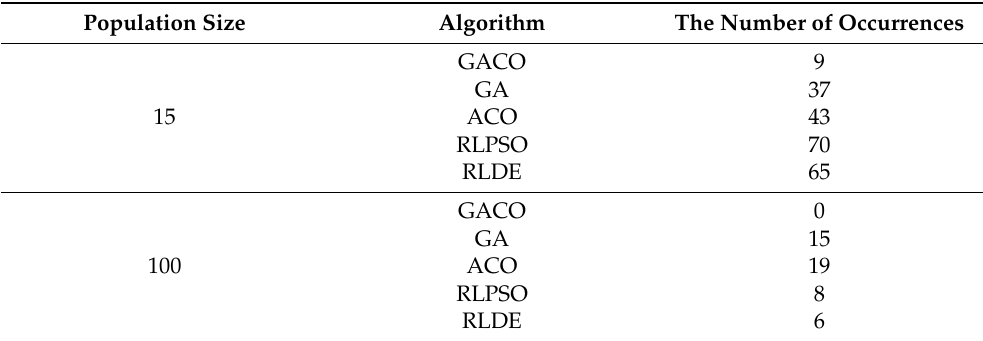
Table 10. The number of occurrences of local optimal solutions of each